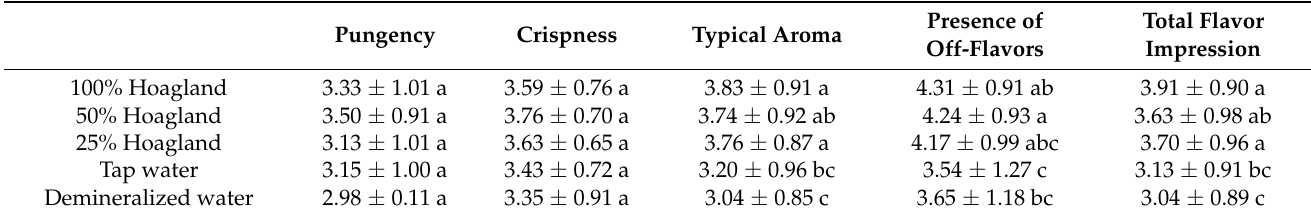
Table 13. Total flavor impression of radish cress rated by untrained consumer tests. Different letters within a column indicate significant differences by Friedman tests.